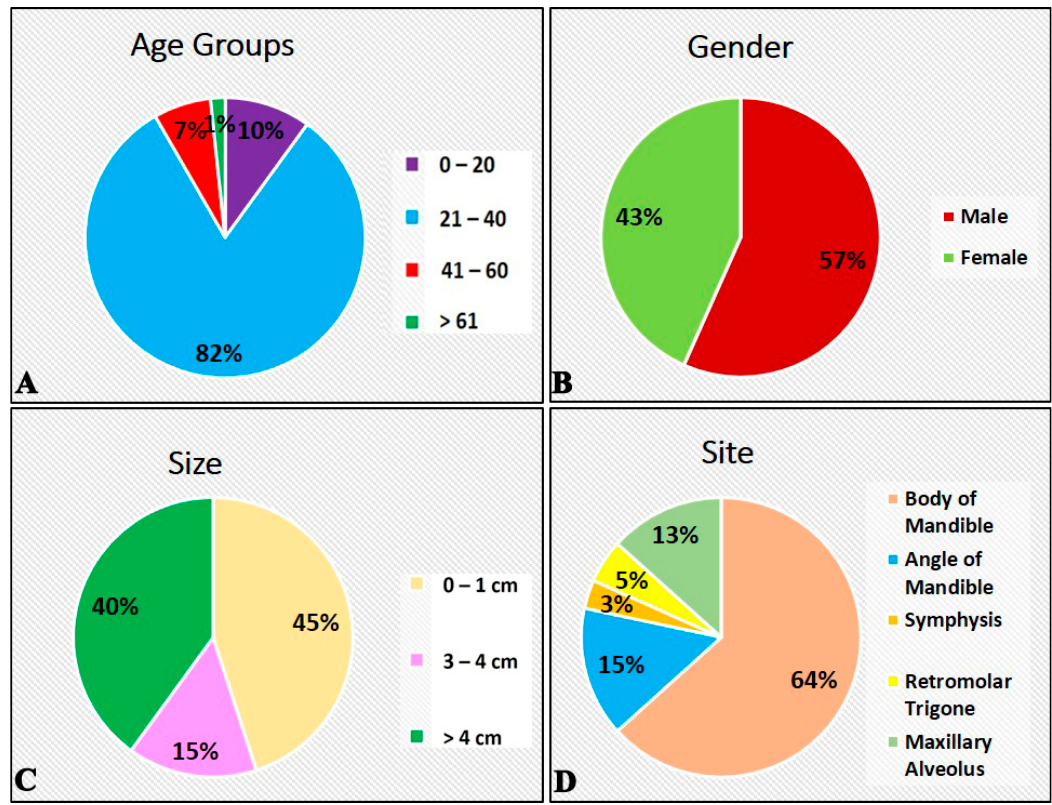
Figure 1. Descriptive features of participants with solid multicystic ameloblastoma. ( A ) Age distribution. ( B ) Gender distribution. ( C ) Size distribution. ( D ) Site distribution. Table 1. Descriptive features of participants with solid multicystic ameloblastoma.